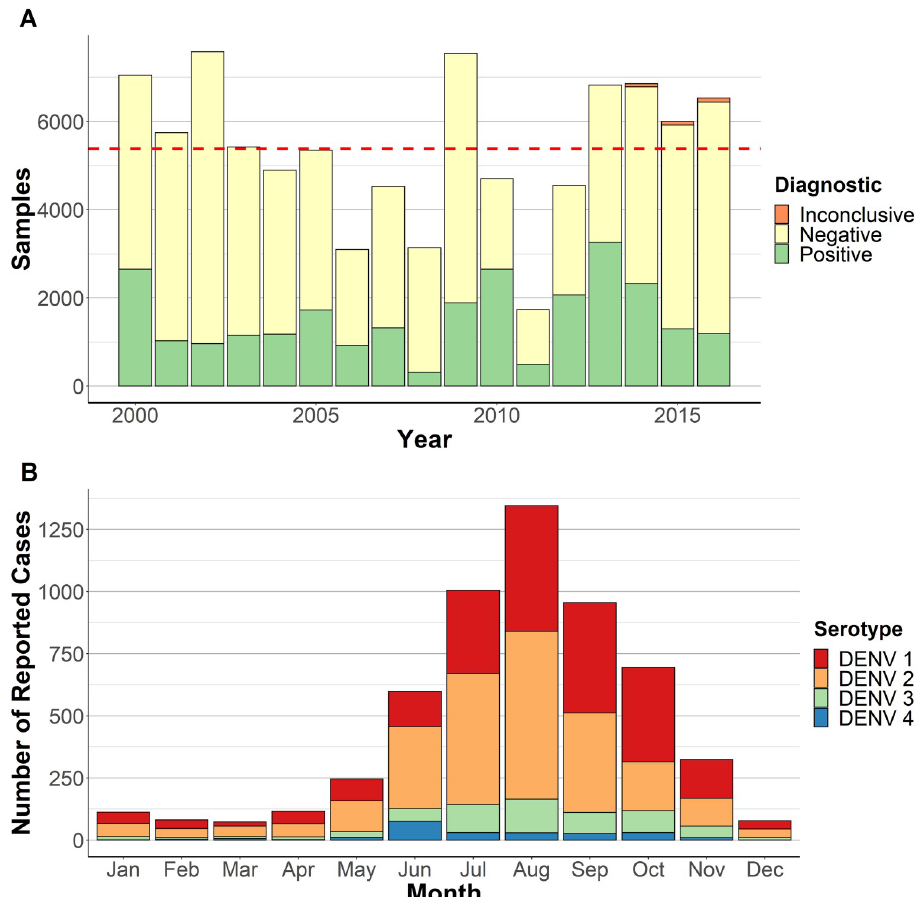
Fig 1. Temporal distribution of dengue in Guatemala. A. Annual number of samples received for dengue screening. The dashed line indicates the mean number of samples submitted across the study period (~5,300). B . Cumulative number of monthly cases of dengue serotypes 1, 2, 3, and